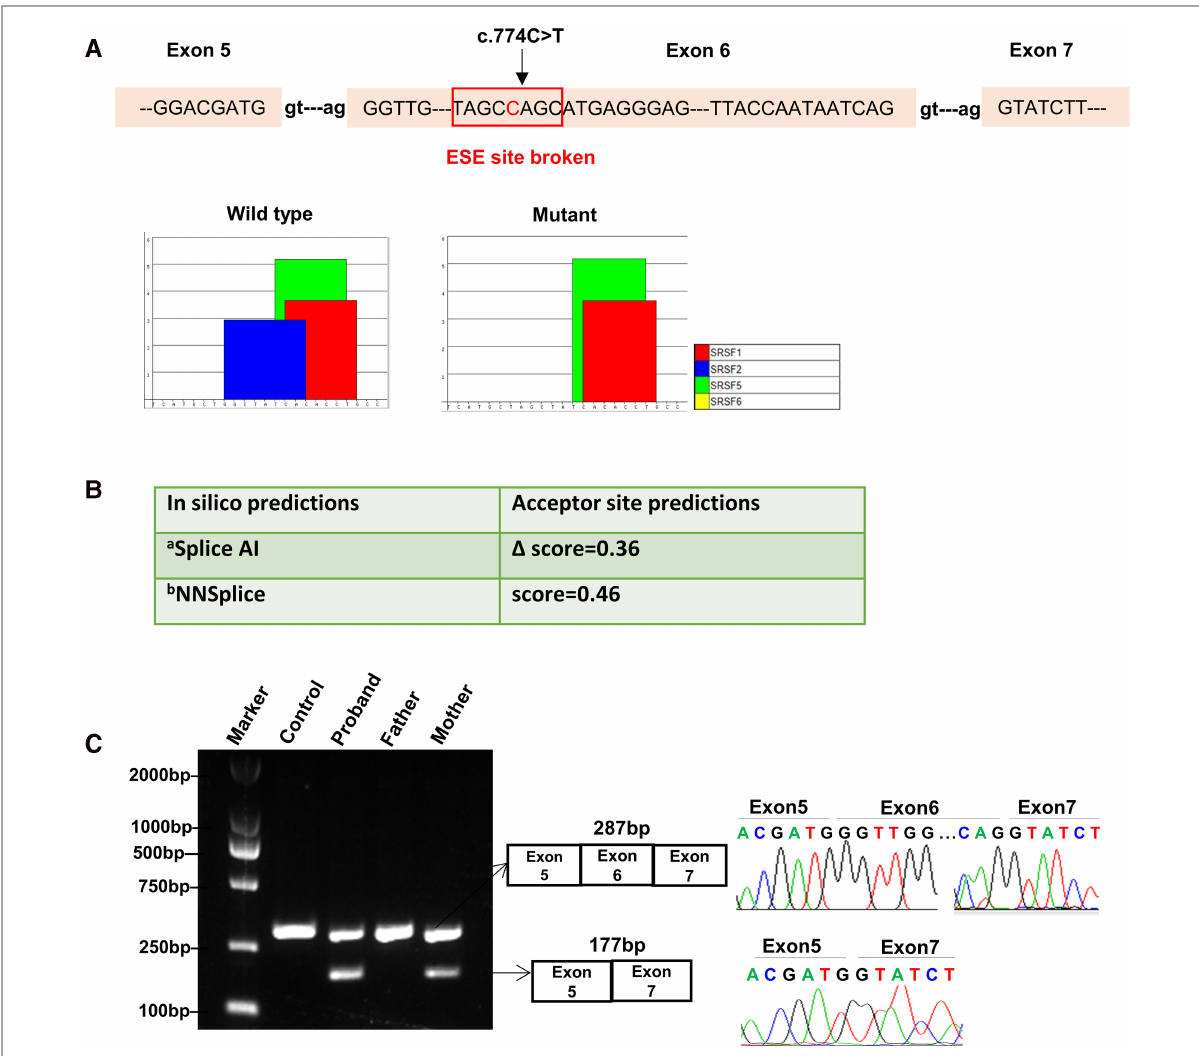
FIGURE 2 Bioinformatics predictions and transcript analysis in vivo for the synonymous variant c.774C>T in the MBTPS1 gene. ( A ) ESE Finder 3.0 program predicted that c.774C>T might affect auxiliary cis-acting splicing regulatory elements by destroying the original exonic splicing enhancer (ESE) binding to SRSF2. ( B ) In silico prediction results for c.774C>T using Splice AI and NNSplice. a, Delta score of a variant can be interpreted as the probability of the variant being splice-altering: 0.2 (high recall), 0.5 (recommended), and 0.8 (high precision) cutoffs.; b, Splice site predictions for acceptor score cutoff 0.40. ( C ) Gel electrophoresis of RT-PCR fragments in vivo showed that c.774C>T caused abnormal mRNA splicing leading to two transcripts differed by about 100 bp. Sequence analysis of the patient and mother ’ s mRNA derived RT-PCR products showed that the shorter transcript lacked a sequence corresponding to exon 6 of the MBTPS1